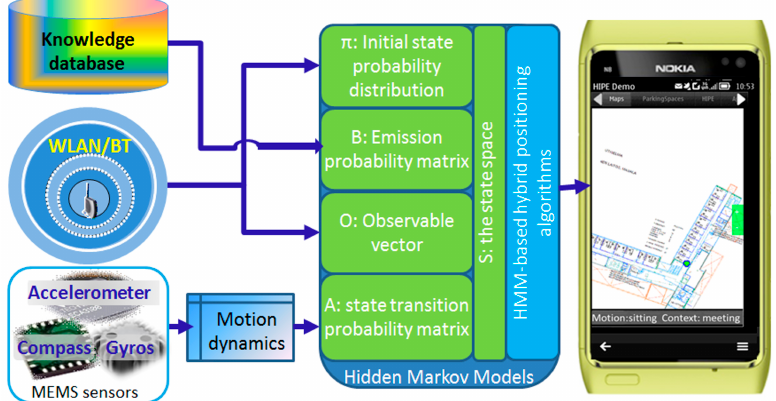
Figure 4. Architecture of a smartphone hybrid indoor positioning solution that combines measurements of multiple sensors and wireless networks and radio signals mapping knowledge database. Five elements of HMM are determined using different types